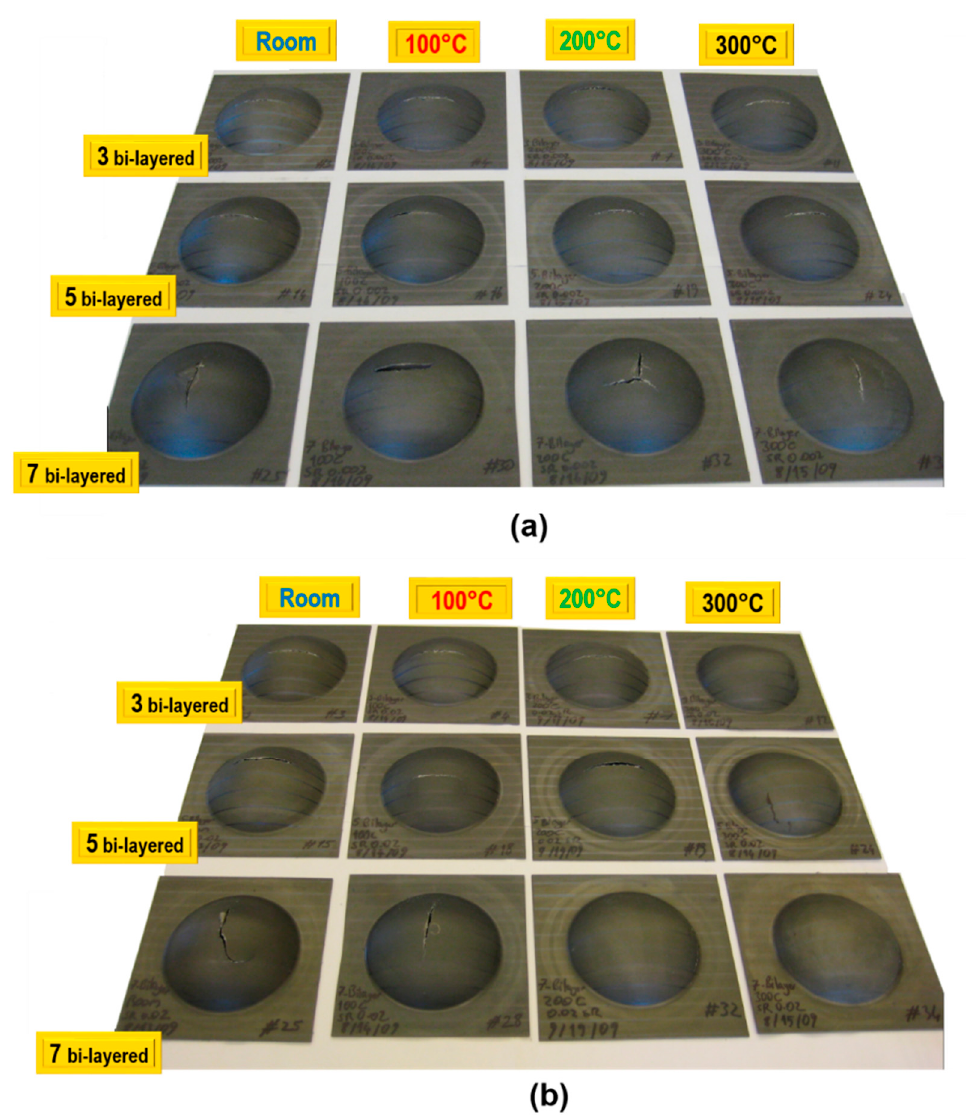
Figure 8. LMC samples in a different number of bi-layers tested at ( a ) 0.0013/s and ( b ) 0.013/s strain rates.